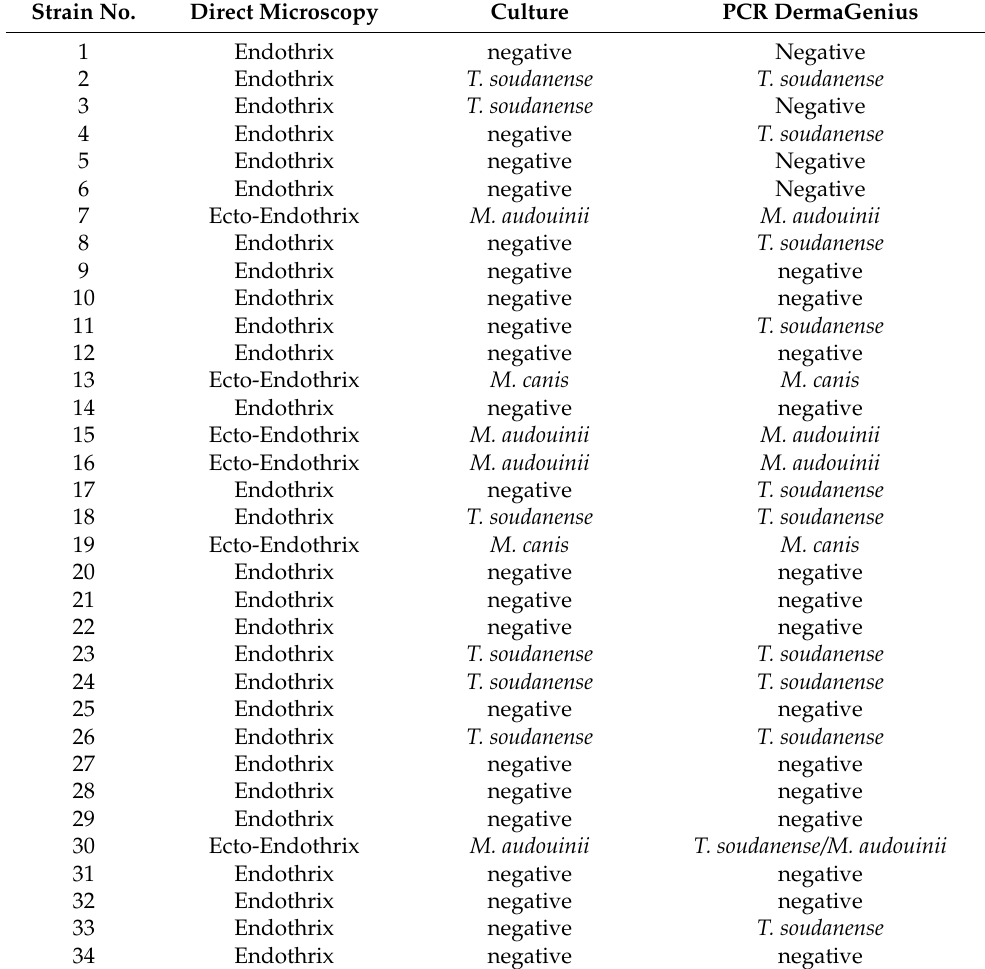
Table 1. Strain information, with a summary of microscopy, culture, and PCR DermaGenius results. Strain No. Strain